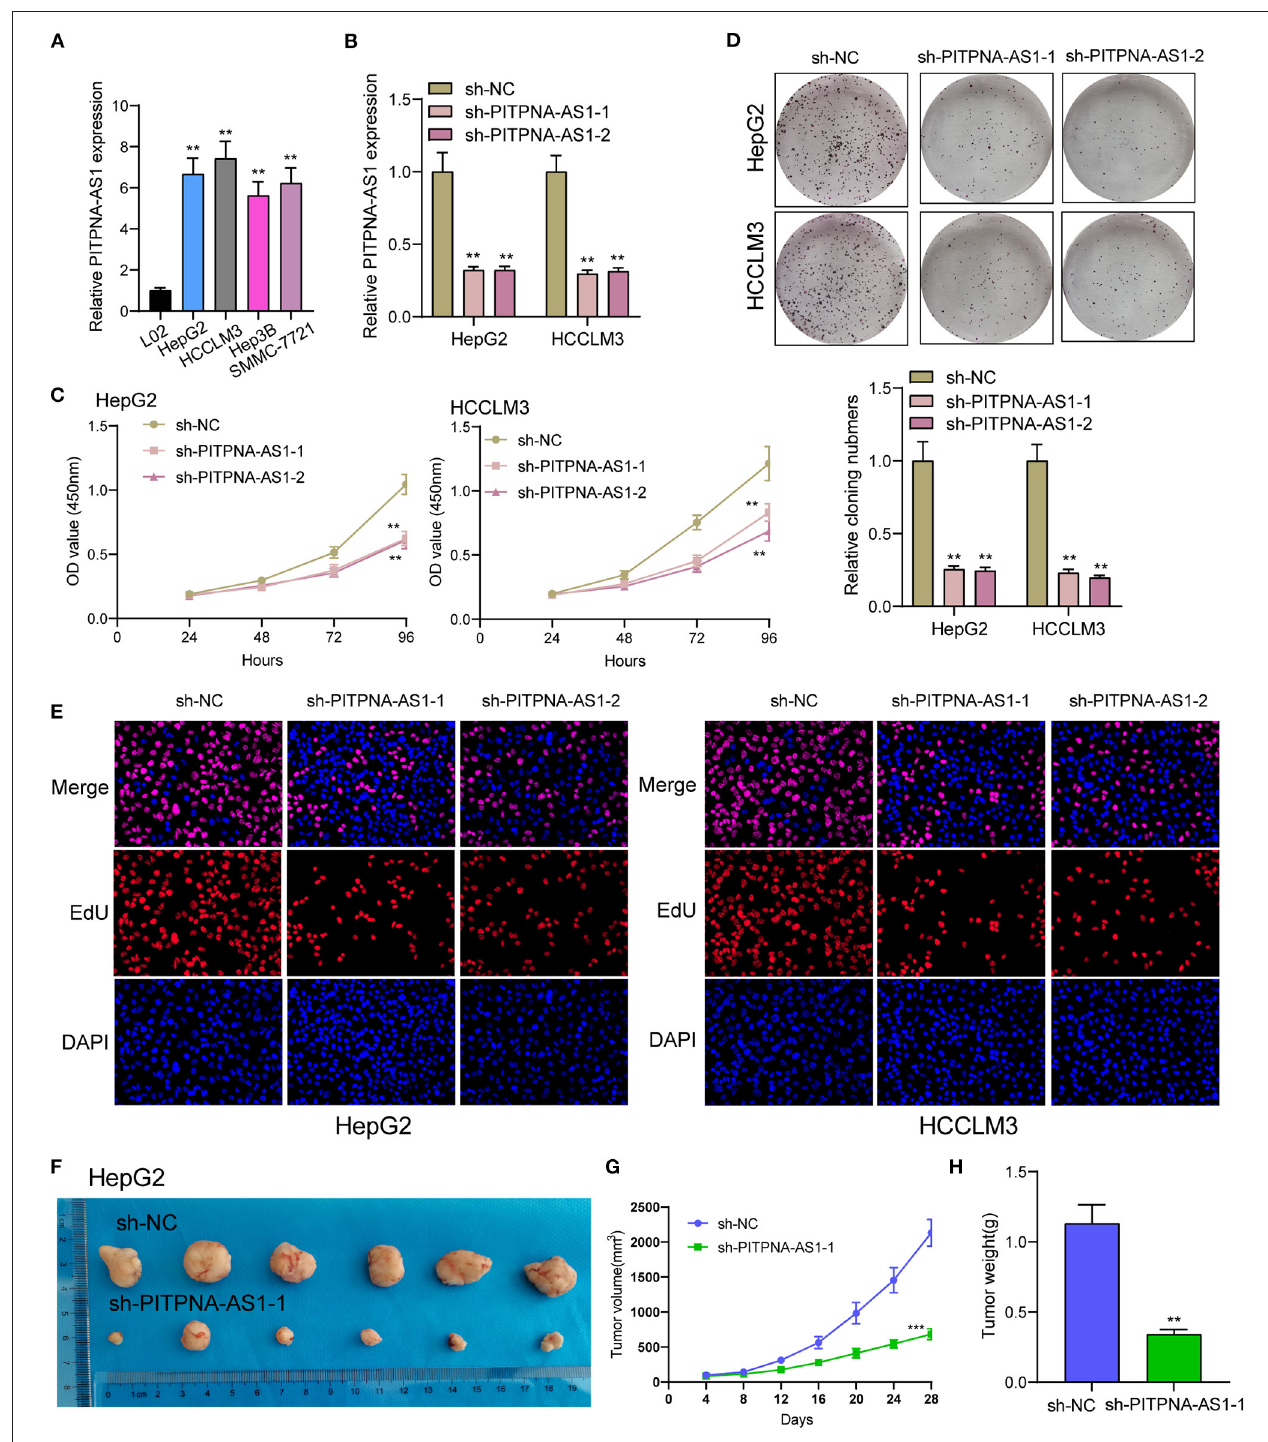
FIGURE 2 | PITPNA-AS1 promotes HCC cell proliferation in vitro and in vivo . (A) The expression in four HCC cells and LO2 cells was determined by RT-PCR. (B) RT-PCR confirmed the transfection efficiency of sh-PITPNA-AS1-1 and sh-PITPNA-AS1-2. (C) CCK-8 assays were performed to detect the proliferative abilities of the transfected HepG2 and HCCLM3 cells. (D) A colony-forming growth assay was performed to determine the proliferation of HepG2 and HCCLM3 cells after treatments. (E) EDU staining assays were applied to detect the proliferation of sh-PITPNA-AS1-1 and sh-PITPNA-AS1-2-transfected HCC cells. (F) Total number of tumors after removal from the mice. (G) Tumor growth curve. HepG2 cells were transfected with sh-NC or sh-PITPNA-AS1-1, and then injected into nude mice ( n = 6), respectively. (H) Tumor weight were represented. *** P < 0.001, ** P < 0.01.